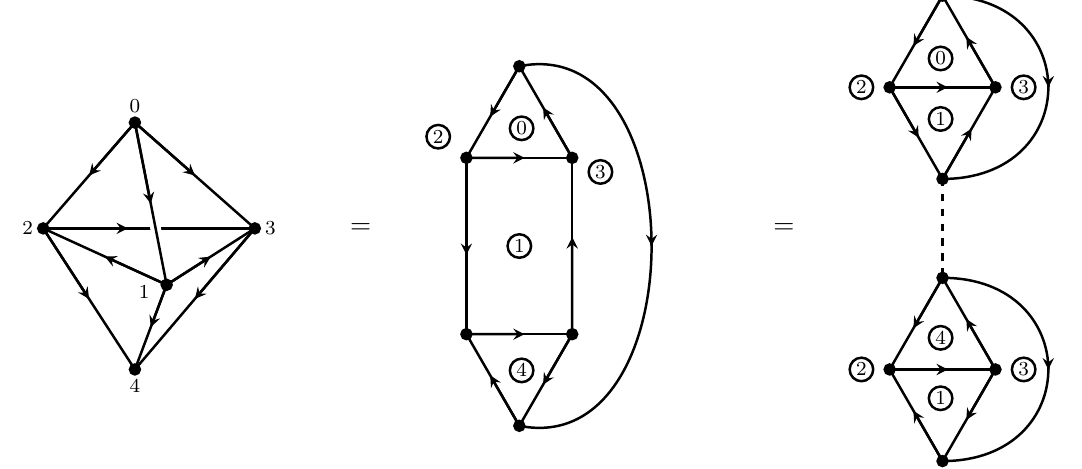
Figure 31 . A triangular bi-pyramid (Right) can be obtained by gluing two tetrahedra. Cor- respondingly, the dual planar graph (Middle) can be obtained by fusing tetrahedral dual planar graphs along a pair of junctions (Right). For clarity, the faces dual to the original vertices are indicated by circled